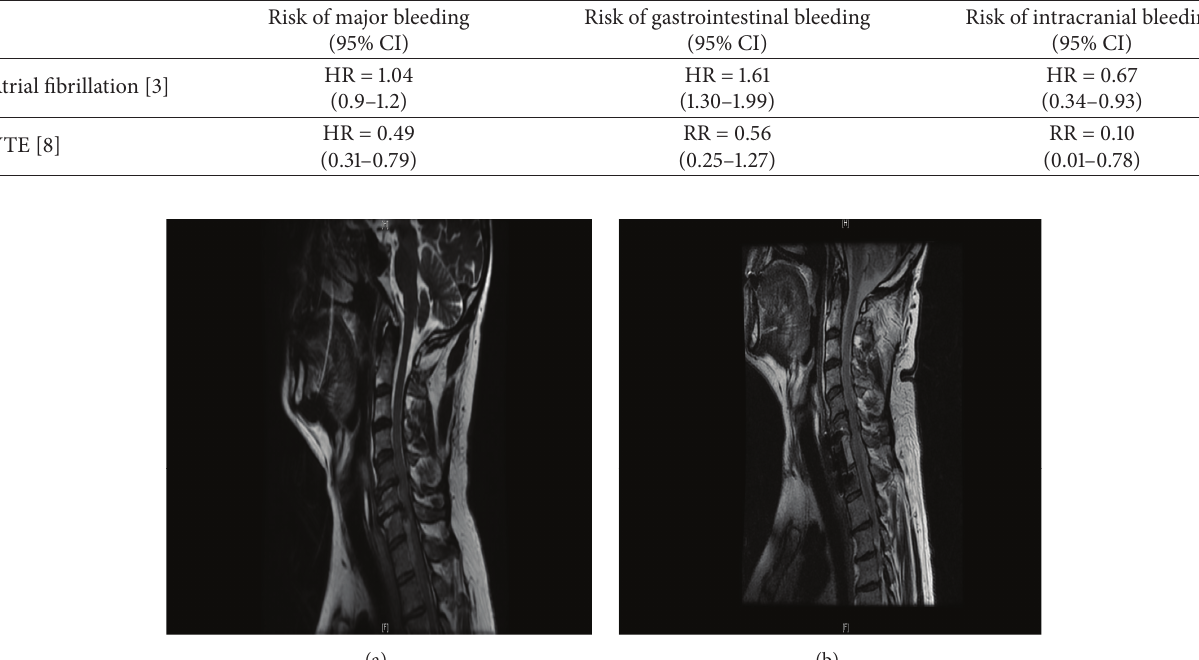
Figure 1: (a) T2-weighted sagittal image of the cervicothoracic spine illustrates a hyperintense 6.3 × 0.6 × 1.6cm fluid collection from C7 to T2 vertebral bodies, with complete effacement of the CSF space and spinal cord edema. (b) T2-weighted sagittal image of the cervicothoracic spine performed 6 weeks after the surgical intervention shows resolution of the spinal fluid